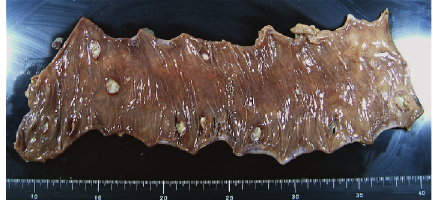
Figure 2: Macroscopic findings of resected transverse colonic spec- imen show multiple perforations. Perforated holes with circular- shape are each from 5 to 10mm in diameter.